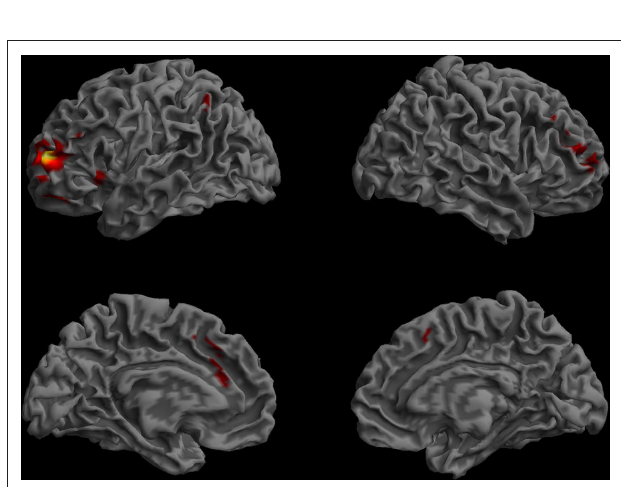
Figure 10 | Functional connectivity of the BA46 rOi. (Lateral and medial views of the left and right hemispheres, p < 0.01, corrected, cluster extent > 100 mm 3 , colors indicate t -values, dark red = lowest, yellow- white = highest, with the voxels within the ROI showing the highest correlation).